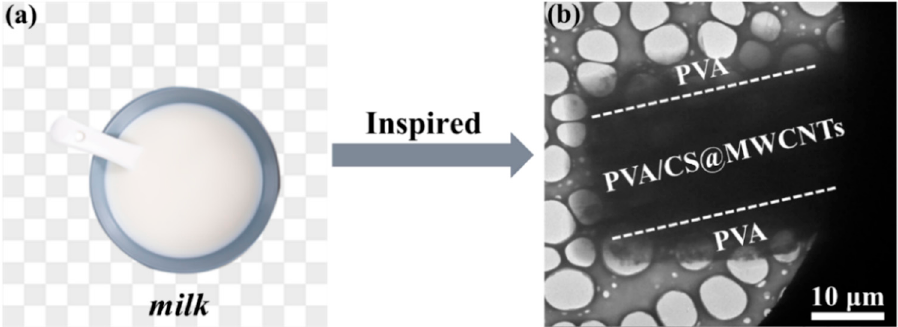
Figure 5. ( a ) Photographs of surface film formation of milk; ( b ) TEM fracture morphology of the PVA/CS@MWCNTs-5 wt% composite film.